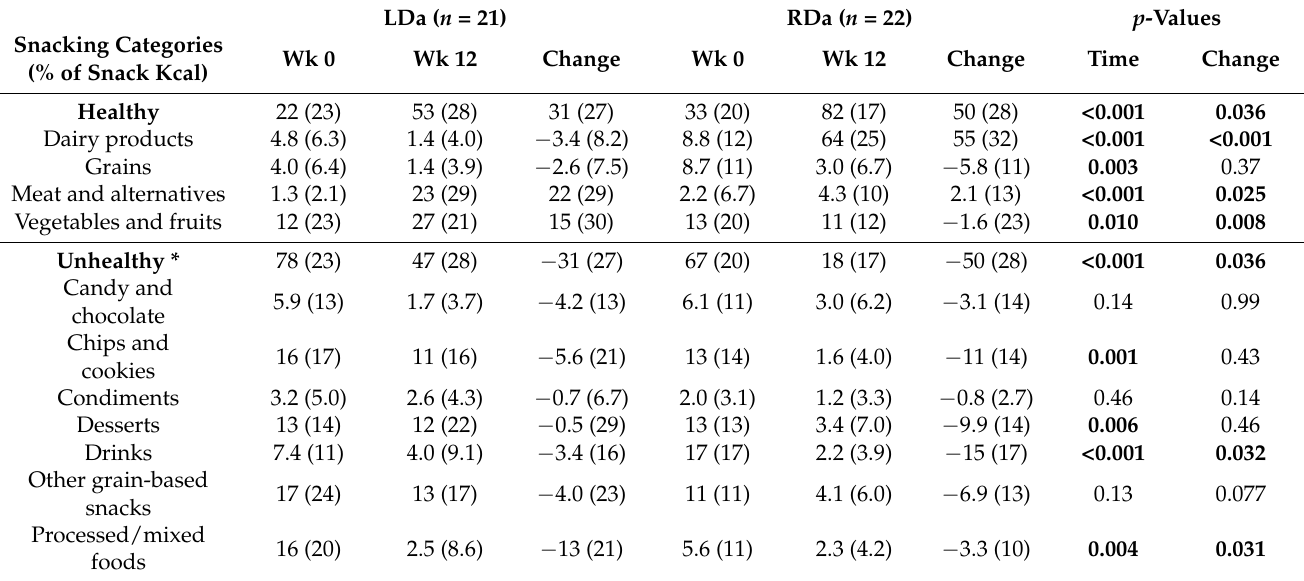
Table 5. Snacking patterns in adolescent females with overweight/obesity in the low dairy prod- uct intake (LDa) and recommended dairy product intake (RDa) groups at weeks 0 and 12 of the intervention. LDa ( n = 21) RDa ( n = 22) p